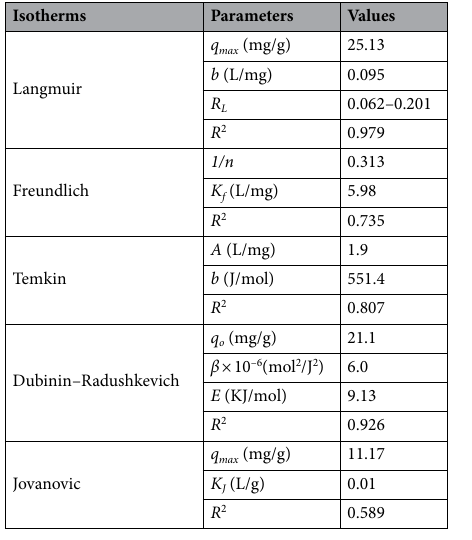
Table 5. Isotherm model parameters of the biosorption of Cu 2+ ions onto R. damascena